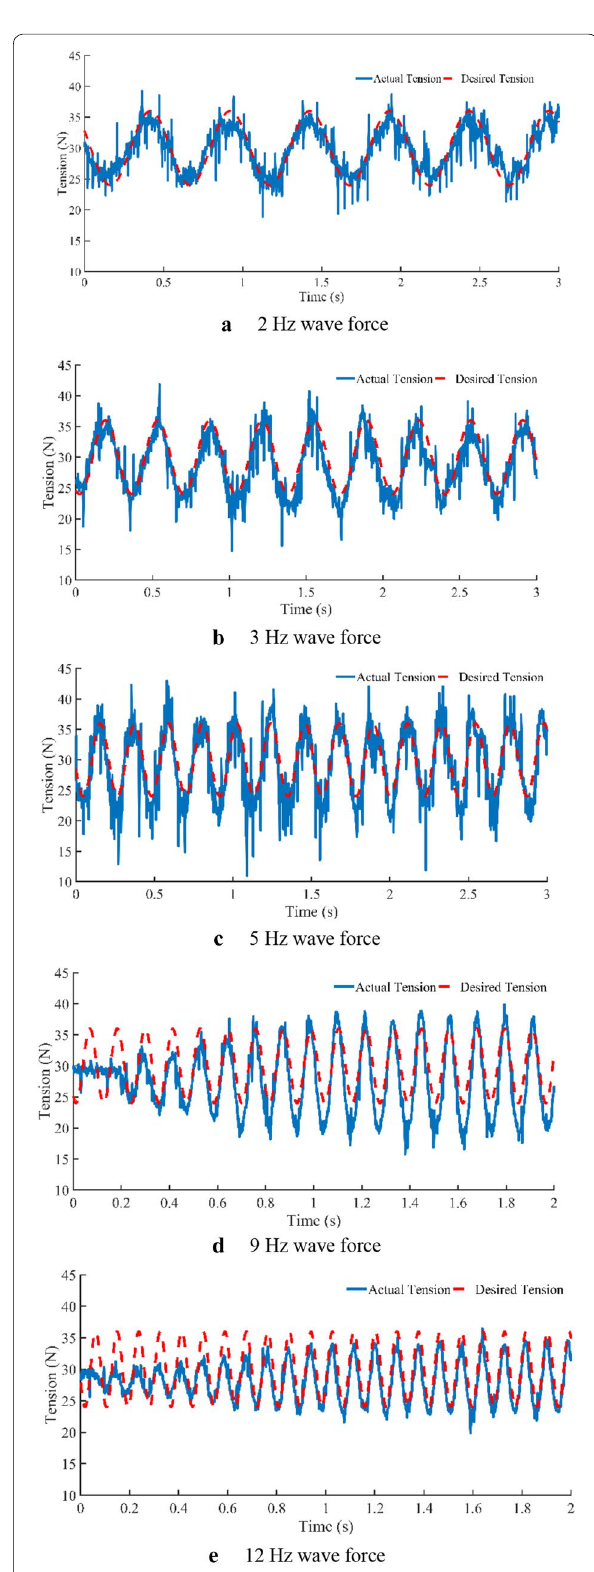
Figure 13 Results of undulation-force output